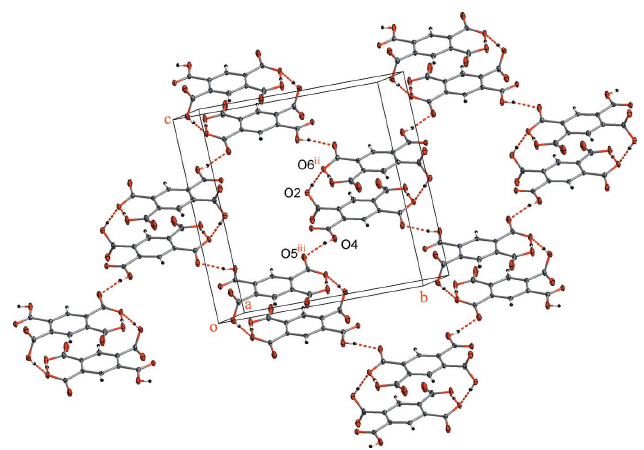
Figure 2 Supramolecular sheet, formed by O—H (cid:2)(cid:2)(cid:2) O hydrogen bonds (shown as [Symmetry codes refer to Table 2.]